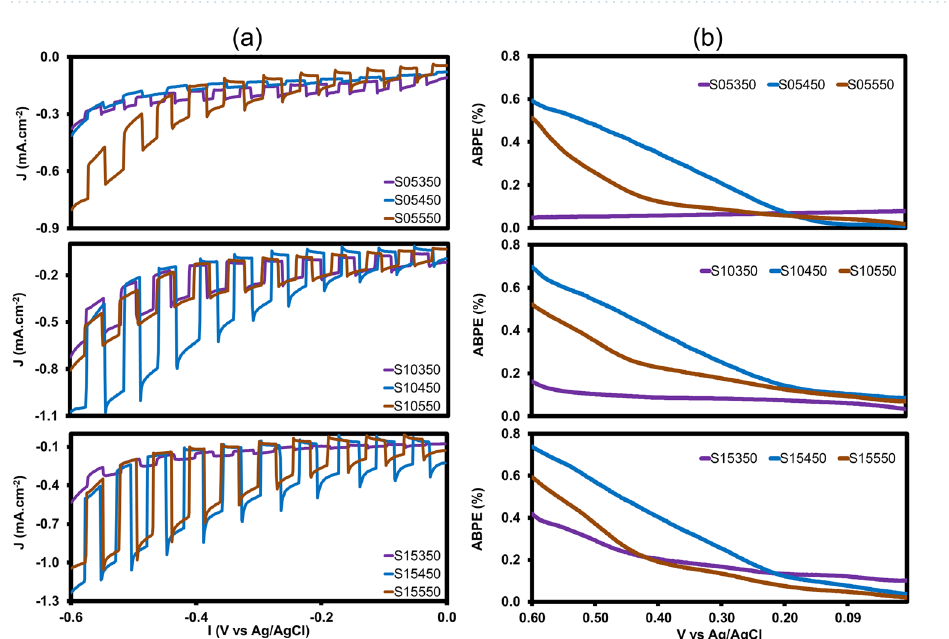
Figure 5. ( a ) Comparison of current density (chopped linear scanning voltammetry (LSV)) in a 0.1 M Na 2 SO 4 electrolyte solution at pH 6.89 under illumination using Xe lamp (AM1.5G 100 mW/cm 2 ); ( b ) Applied bias photo-to-current efficiencies (ABPEs) of FTO/CuO/CuBi 2 O 4 photocathodes obtained from three-electrode configuration calculated and plotted from LSV data (Eq.